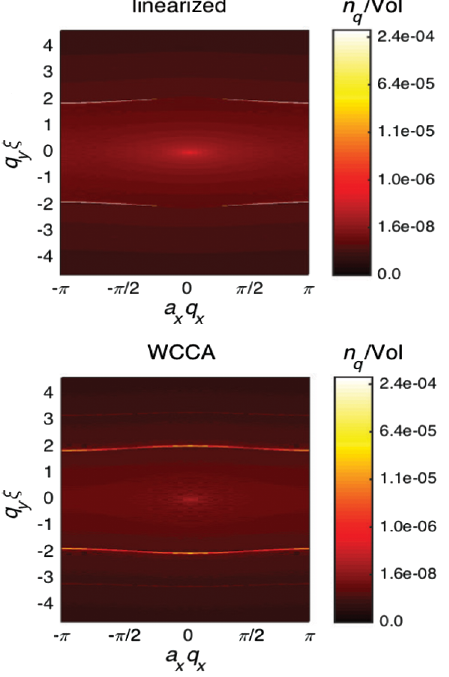
FIG. 17. Quasiparticle momentum distribution function n after q a duration of t ¼ 1000 T , for the 2D band model from Sec. VI B (with a lattice along the x direction and continuum along the y direction). The top panel shows the linearized mean-field model, while the bottom panel shows the conserving approximation (WCCA) to order U . The model parameters are the same as in 1 to unity, while Fig. 16. Here, we set the lattice constant a x ¼ ξ ¼ 1 . 47 a denotes the BEC healing length. x